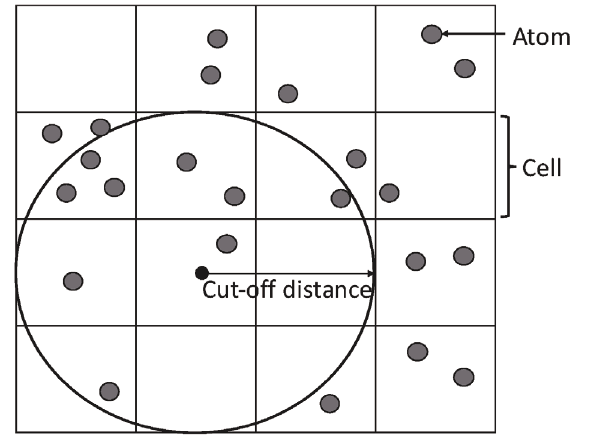
Fig. 3. Division of the simulation box in to